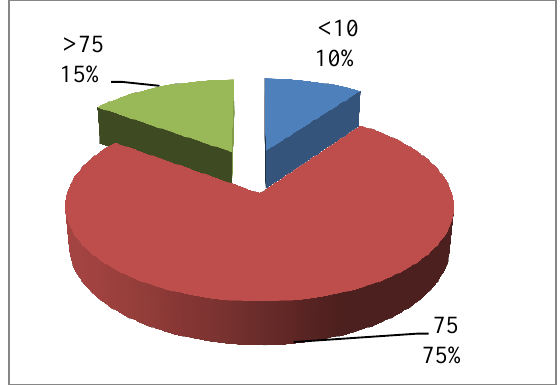
Fig. 4. Characterization of proteins by molecular weight of C. tropicalis , fungi cells obtained with grinding